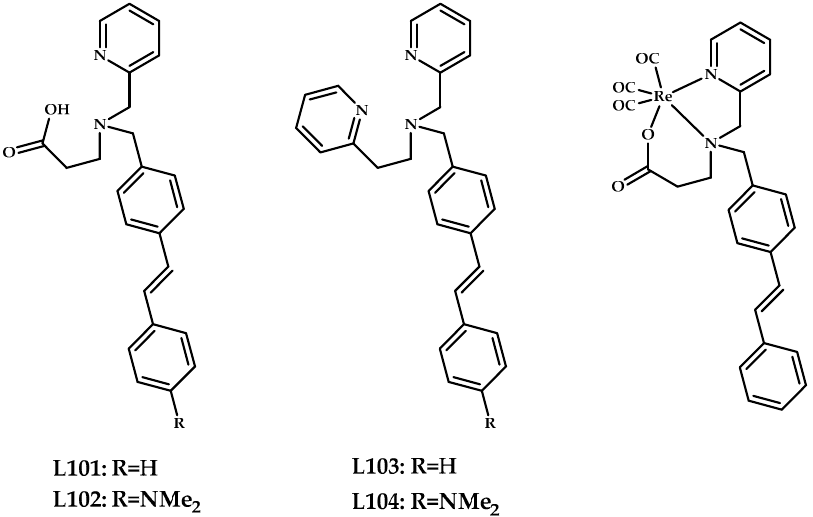
Figure 25. Tridentate ligands L101 – L104 conjugated with a stilbene A β -binding moiety designed for A β plaques binding, and the proposed structure of coordination compound 101 .